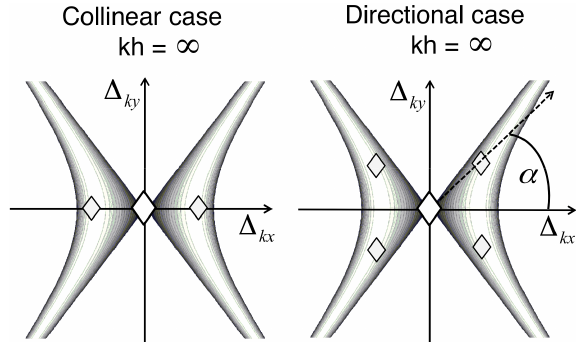
Fig. 2. Instability region and location of side bands for kh = 1 . 36: collinear disturbances (left panel); oblique disturbances (right